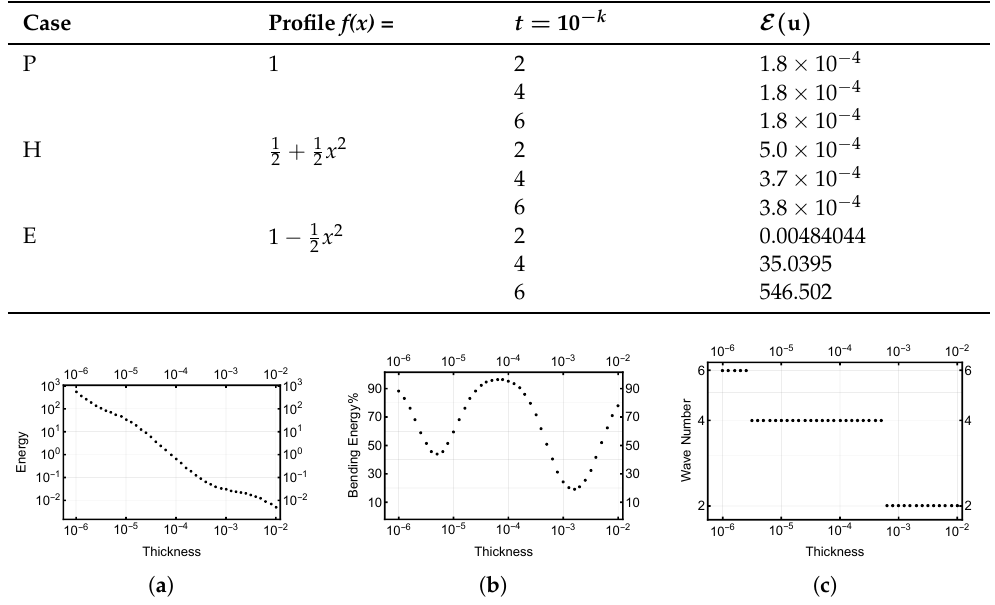
Figure 7. Elliptic reference case (E). ( a ) E ( u ) . ( b ) B ( u ) . ( c ) Angular wave number.